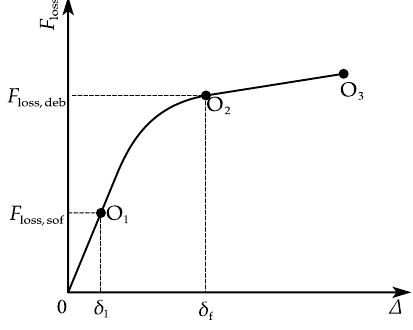
Figure 6. Typical prestress loss–displacement curve at the breaking point.